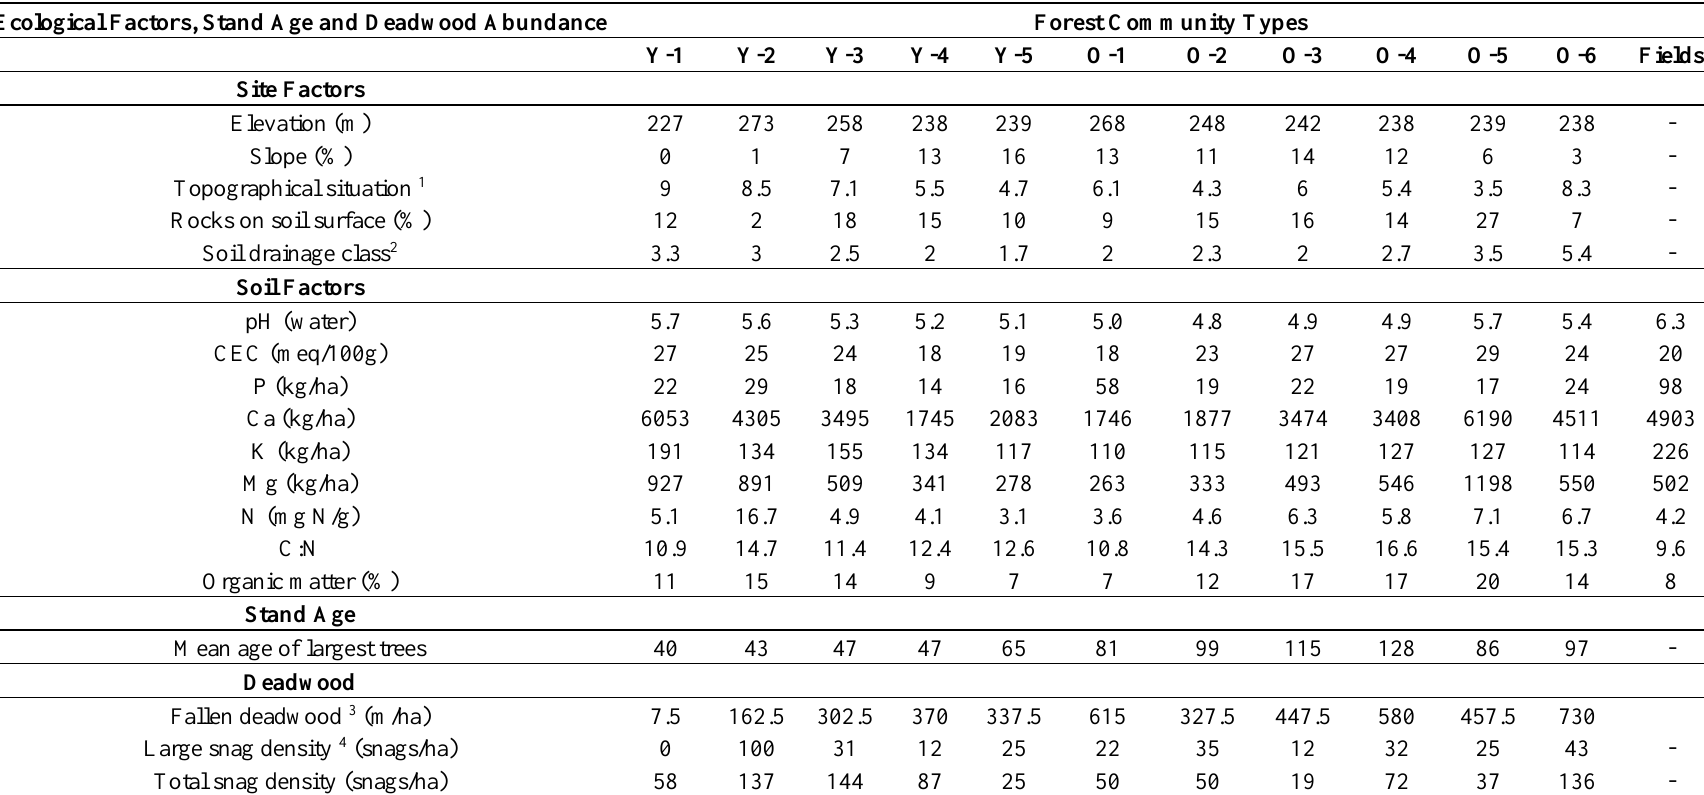
Table 3. Means of site factors, soil factors, stand age and deadwood (snags and coarse woody debris) abundance for the Young (Y) and Old (O) Forests community types of the St-Benoît-du-Lac Abbey forested areas. Community type codes: Y-1, grey birch—balsam poplar—elm; Y-2, balsam fir; Y-3, white ash; Y-4, largetooth aspen; Y-5, white pine; O-1, maple—white ash; O-2, sugar maple—beech; O-3, hemlock—sugar maple; O-4, hemlock—sugar maple—yellow birch; O-5, hemlock—yellow birch—black ash; O-6, white cedar. Soil factors of agricultural fields used for intensive biomass production are also indicated (Fields).